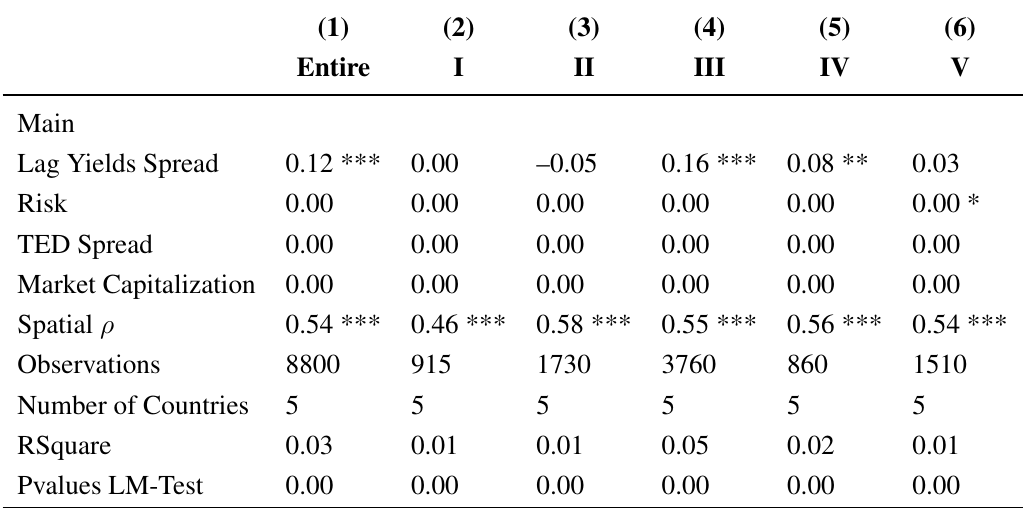
Table 3. Empirical results for low exposed countries to the sovereign debt